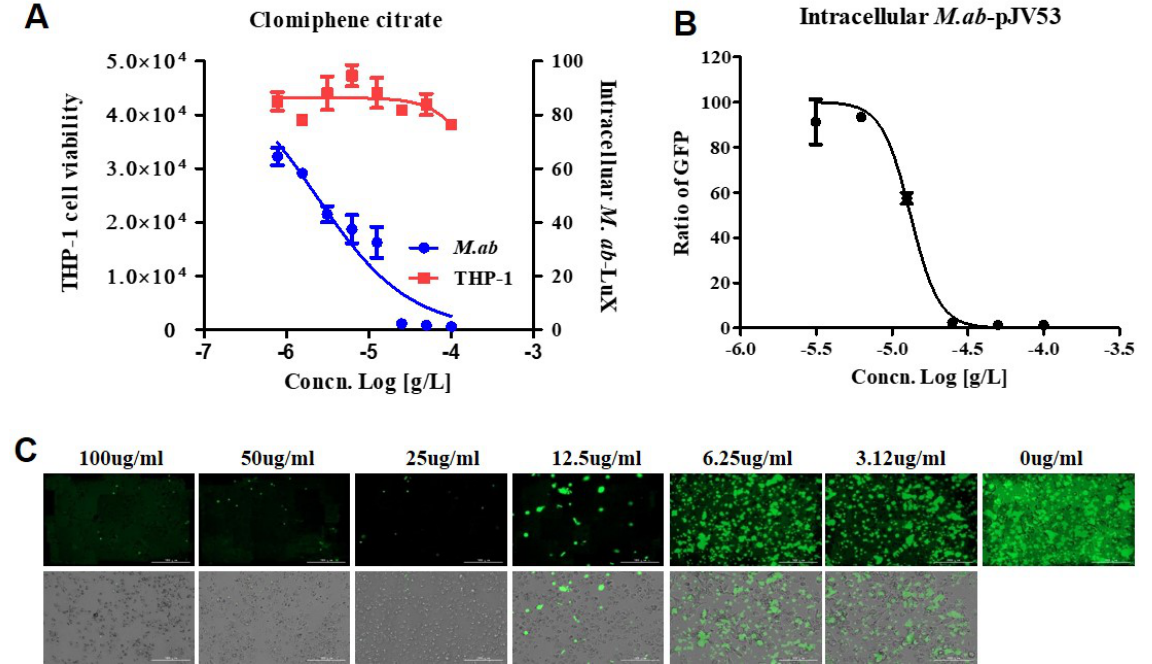
Figure 5. CC promotes the killing of intracellular M. abscessus . ( A ) Dual-readout assay of CC within macrophages. Infections in macrophages were carried out with multiplicities of infection (MOI) of two bacteria per cell for 3 h and washed to remove extracellular mycobacteria. Luminescence detected from luciferase-expressing M. abscessus alone within THP-1 macrophages. The infected THP-1 cells stained with SYTO 60 were counted using fluorescence detection, and total cells were counted using Multi Reader. ( B ) THP-1 activated with PMA were infected at MOI of 2 with GFP-expressed M. abscessus for 3 h, followed by treatment with CC-indicated concentrations in fresh medium. Ratio sum intensity values were used for all data reduction steps. ( C ) Images of GFP-expressing M. abscessus infected THP-1 cells on day 3 after treatment with indicated concentrations of CC. Automated microscopy using a Lionheart TM automated live-cell imager. The Gen5 TM 3.05 software object feature enables the identification of cells within the imaging field. Data were expressed as the mean ± SEM of triplication for each concentration. (Scale bar = 100 um). This result was made from a representative experiment.